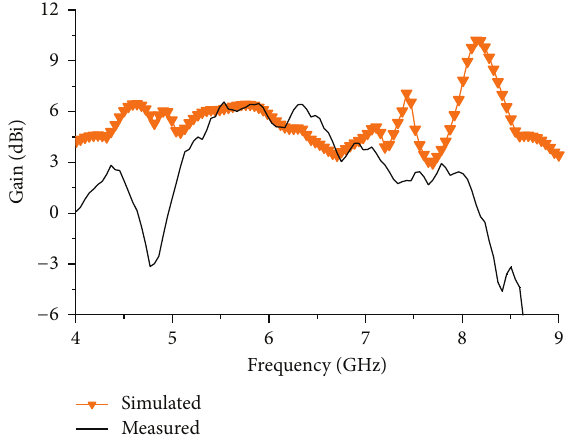
Figure 10: Gain of the proposed microstrip